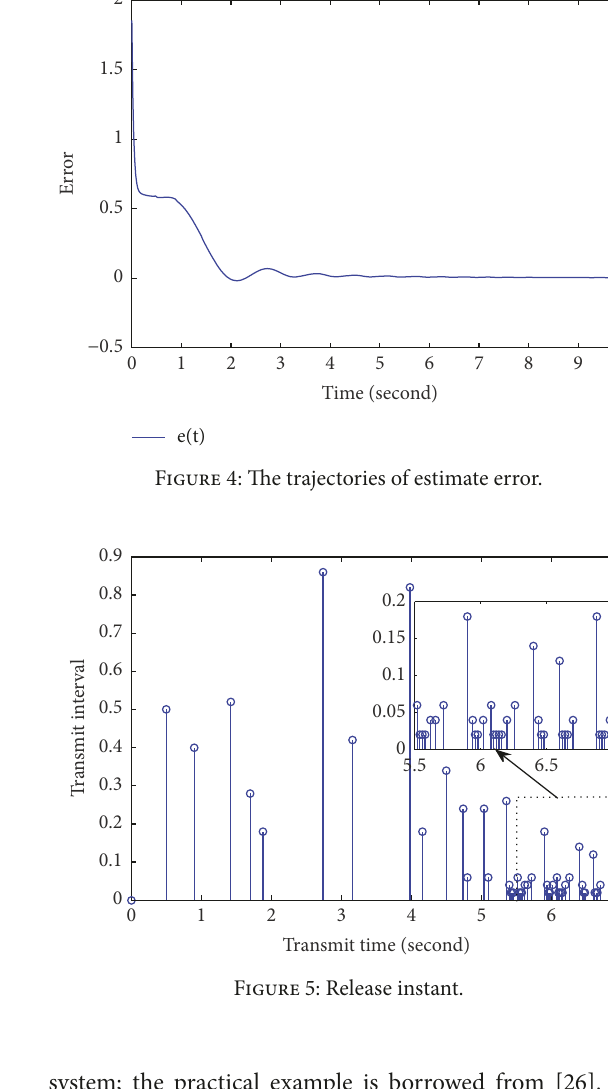
Figure 2: State trajectories of 𝑥 2 .